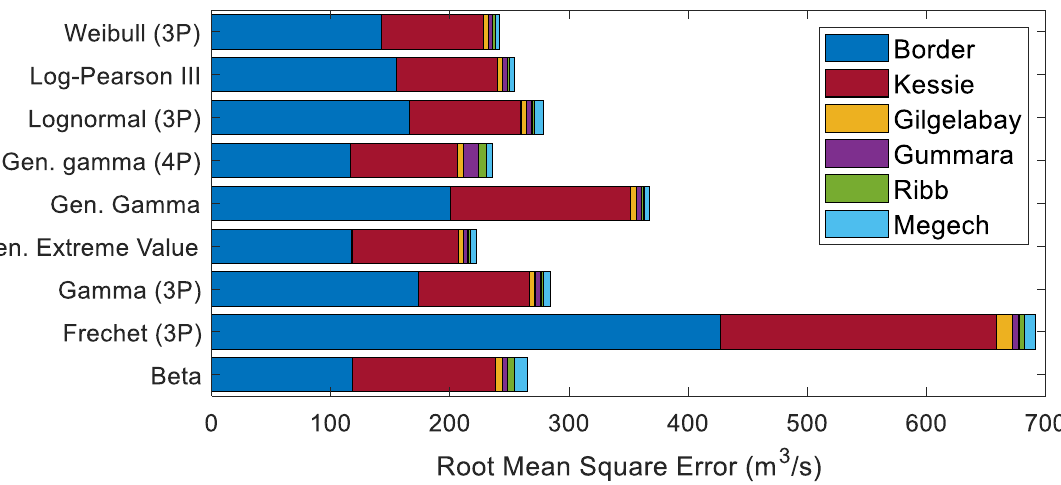
Figure 5. The root mean square error (RMSE) values of the candidate distributions in each gauging station.